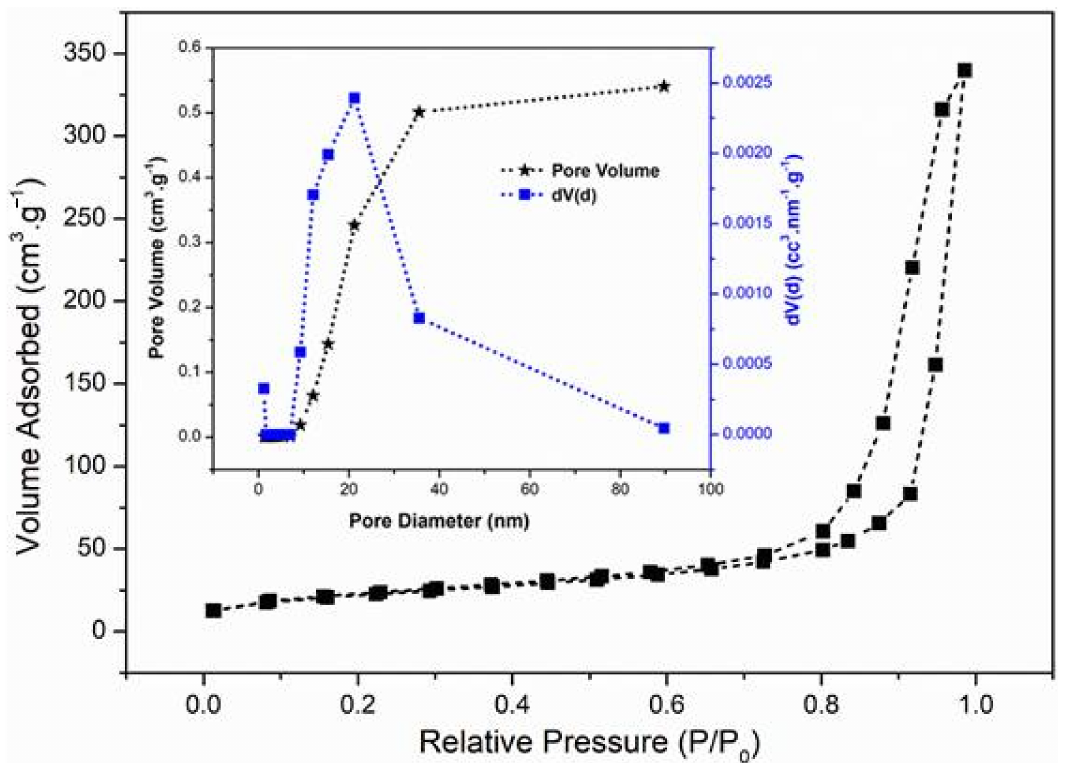
Figure 2. Nitrogen adsorption/desorption isotherm and pore size distribution of bioactive